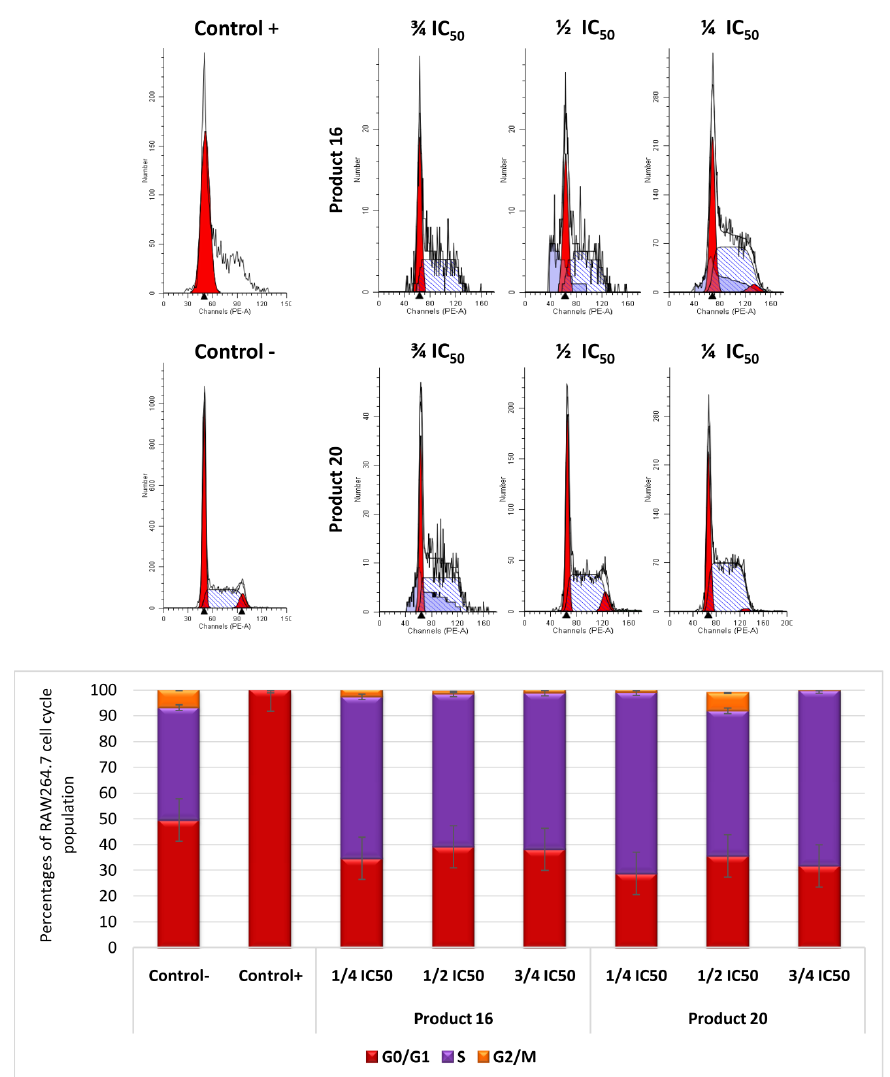
Figure 3. Top: Histograms of the cell cycle of RAW264.7 macrophage murine cells, after 72 h treatment with compounds 16 and 20 , at ¼ IC 50 , ½ IC 50 , and ¾ IC 50 concentrations. Bottom: Increase in the percentage of cells in each cell-cycle phase concerning untreated control cells. The cell cycle was conducted after propidium iodide (PI) staining as described in the experimental section, G0/G1 phase (brown bars), S phase (purple bars), and G2/M phase (orange bars). Values represent means ± S. D. of at least three independent experiments performed in duplicate.